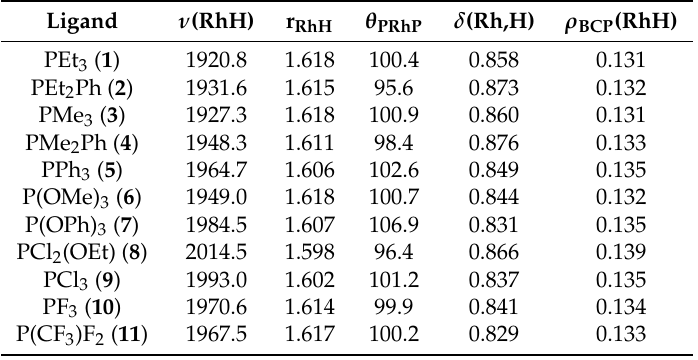
Table 3. Computed Rh-stretching frequencies, Rh–H bond lengths (in Å), P–Rh–P bond angles (in degrees), delocalization indices, and electron densities at bond critical points for HRhL 2 (CO) complexes. Ligand